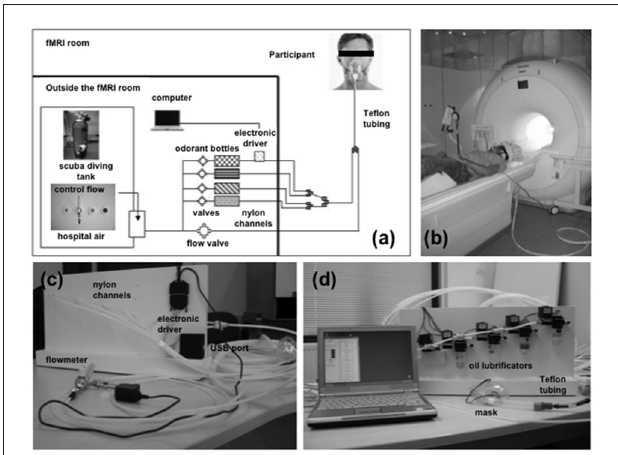
FIGURE 3 | Images of the experimental setup for fMRI study of olfactory processing. (A) Schematic representation of the computer-controlled, MRI-compatible odor delivery system. Outside and partly inside the fMRI room, the five nylon channels transmit odorless pulsed air and odorants in separate ways, until they reach the last 30-cm segment nearest to the participant; these channels converge into a single Teflon tube connected to a mask. Outside of the fMRI room, compressed air—either from a scuba-diving tank or a hospital air-care delivery (constant flow)—provides a clean air supply for the stimulator. Bottles containing the odorants (lemon, banana, lavender, rose) are kept in the odor delivery system. An electronic driver is located in the back of the stimulator device (represented schematically in the figure). The computer that controls the stimulator device is located outside the fMRI room. (B) Image of a volunteer participating in a fMRI experiment using the odor delivery system. Auditory signals that allow synchronization of breathing with odor stimulations are delivered via headphones. (C,D) Overall view of the computer-controlled stimulator device, showing nylon channels, fittings, and Teflon tube that deliver the switched air streams to the participant via a removable medical mask; panel (C) shows the view from the back, showing the flowmeter, the start of the five nylon channels, the main power, and the electronic driver, which is equipped with a USB port; panel (D) gives a detailed front view of the device, showing the solenoid valves and oil lubrificators containing the odors in solution. The main part of the device and the computer remain outside the fMRI room, whereas the five nylon channels are passed to the fMRI room through a conventional security hole. Adapted from Cuevas et al.